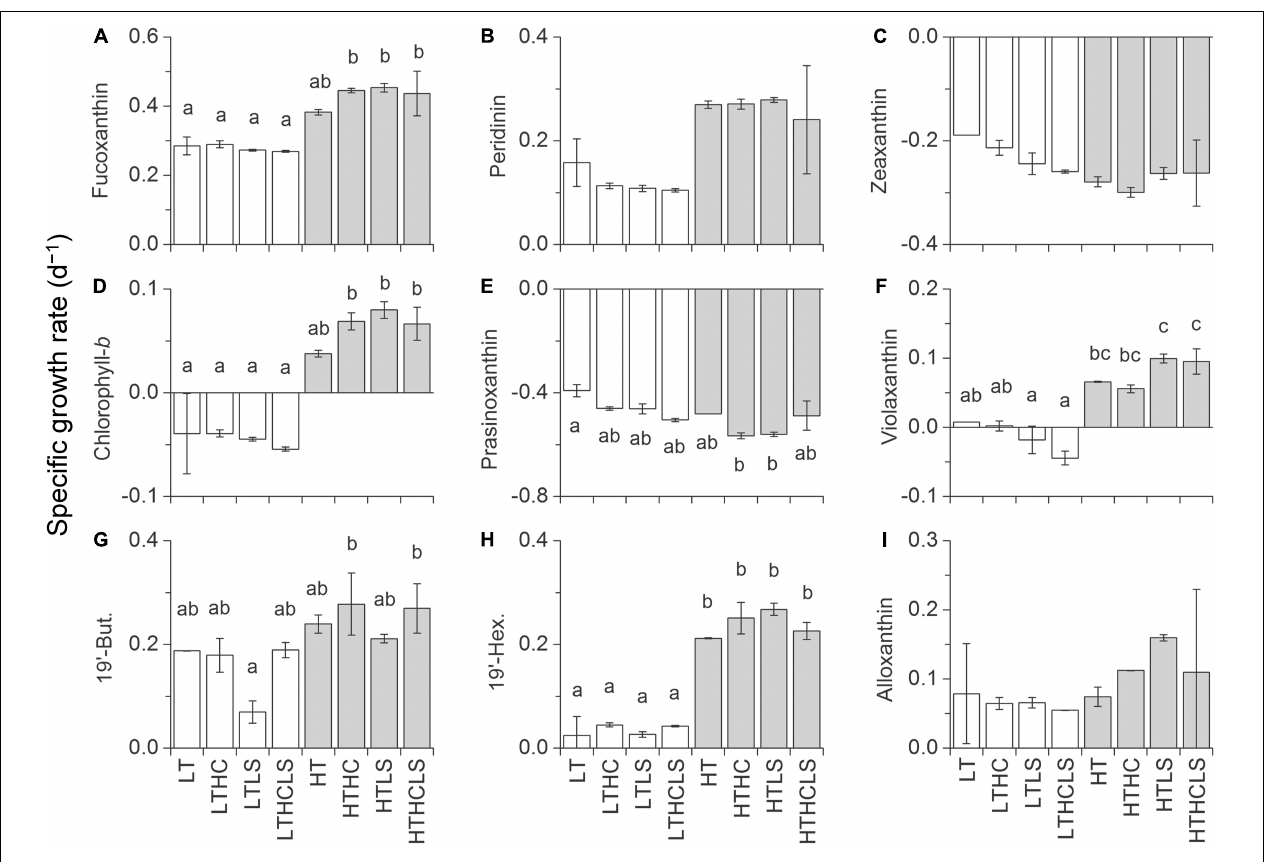
FIGURE 5 | Specific growth rates based on the concentrations of (A) fucoxanthin, (B) peridinin, (C) zeaxanthin, (D) chlorophyll- b , (E) prasinoxanthin, (F) violaxanthin, (G) 19 (cid:48) -butanoyloxyfucoxanthin, (H) 19 (cid:48) -hexanoyloxyfucoxanthin, and (I) alloxanthin in the MR15-exp. Letters above the bars represent statistical results of groups according to the Tukey–Kramer